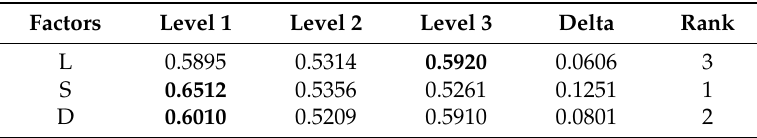
Table 10. Response table of GRGs.